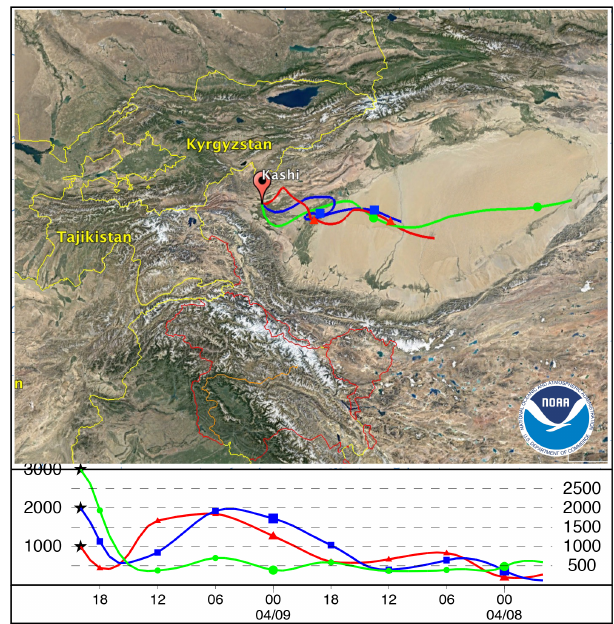
Figure 7. Case 1: the 48h back trajectories ending at 20:00UTC, 9 April 2019, for air masses at 1000, 2000 and 3000m. © Google Maps 2020.